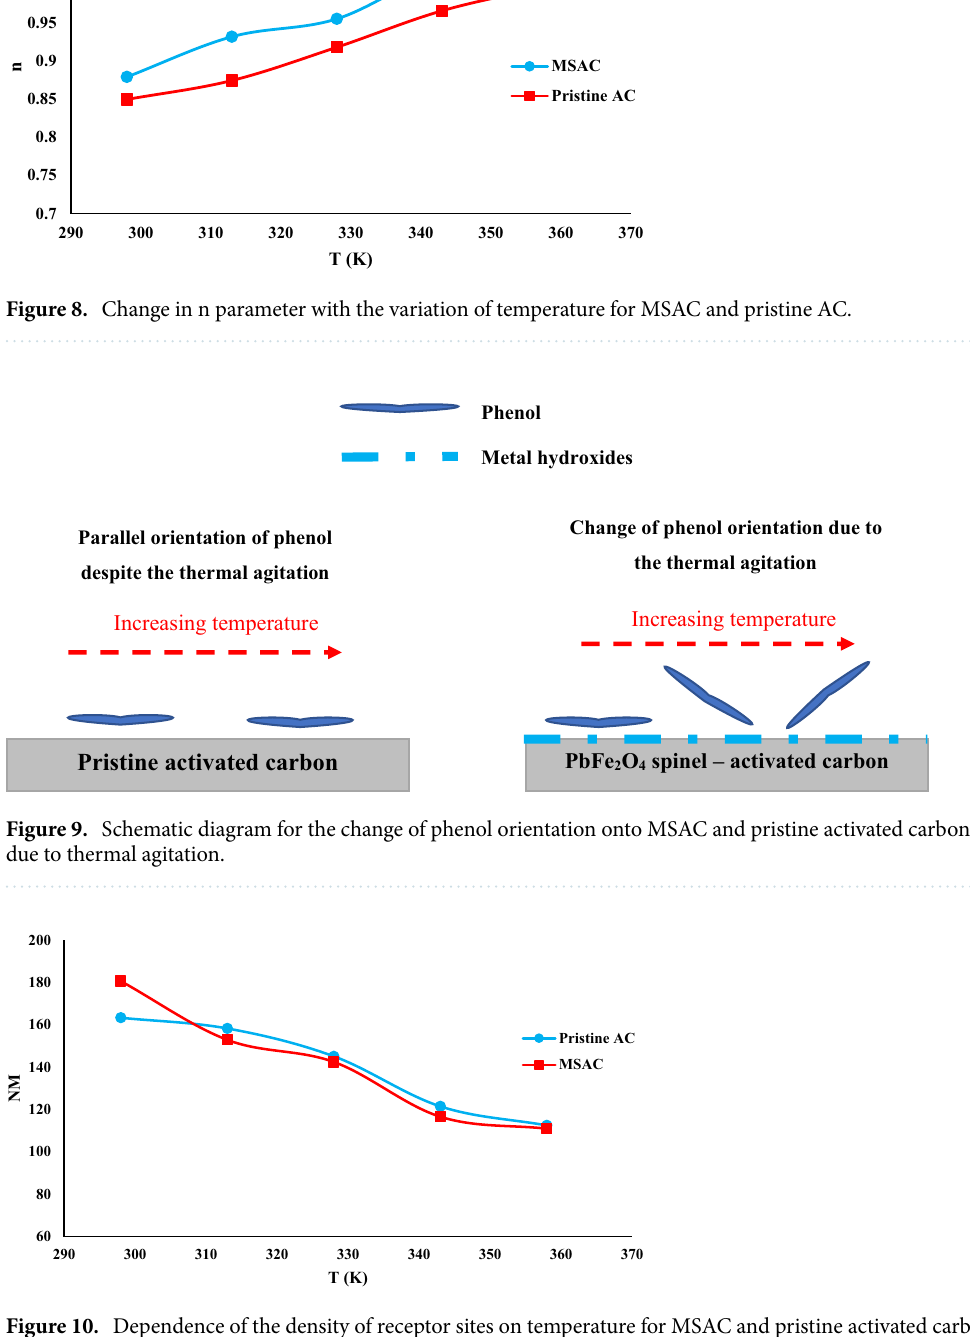
Figure 10. Dependence of the density of receptor sites on temperature for MSAC and pristine activated